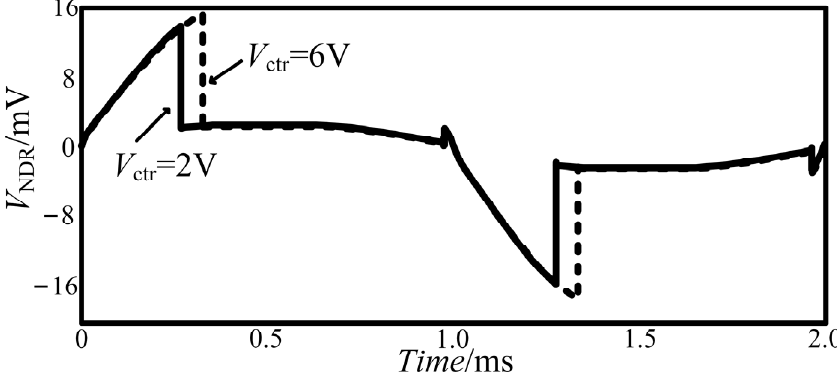
Figure 11. Output curves of V NDR .